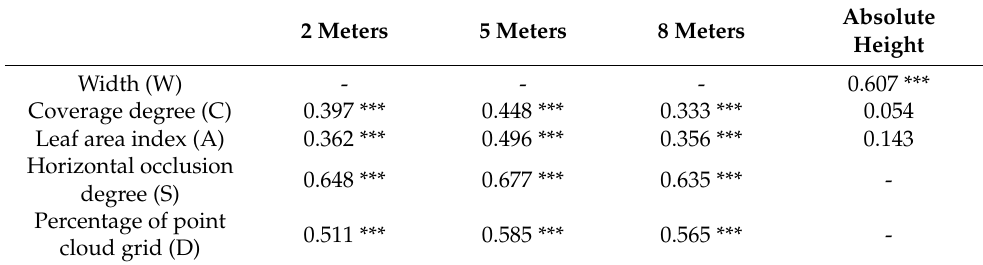
Figure 7. Scatter distribution of characteristic factor indices and actual noise attenuation. W: width, C: coverage degree, A: leaf area index, S: horizontal occlusion degree, D: percentage of point cloud grid. Table 3. Correlation analysis of each index.